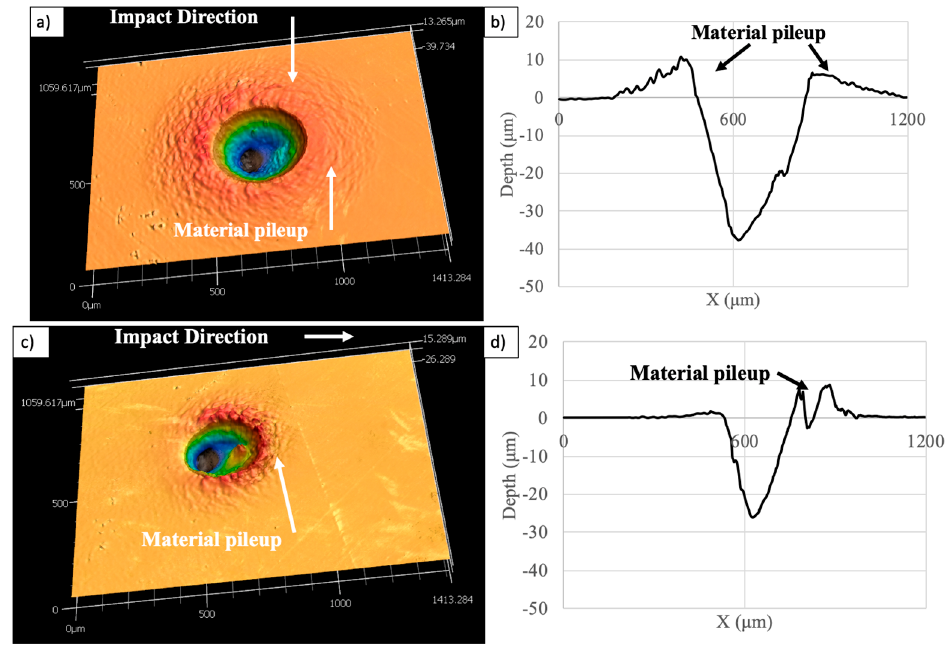
Figure 11. Nanolaminate annealed at 650 °C impact profiles at a 90° a ) confocal b ) depth profile and at a 30° impact c ) confocal and d ) depth profile.